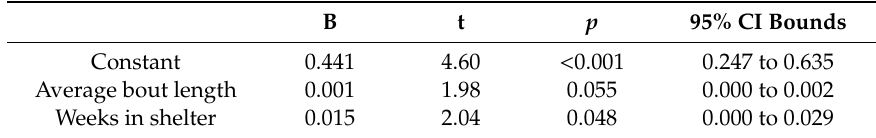
Table 4. Results of univariate general linear regression models comparing variables from the Kong TM anhedonia test to time spent awake but motionless in the home kennel (logarithmically transformed). N = 43 dogs. Average bout length is mean duration of bouts of interaction with the Kong TM . The overall model was significant at the p < 0.05 level: F = 3.66, df = 2, p = 0.035, R 2 = 15.8%. See Table S4 for model statistics from all tests. The 95% CI Bounds indicate the upper and lower 2.5% confidence intervals around the beta (B)